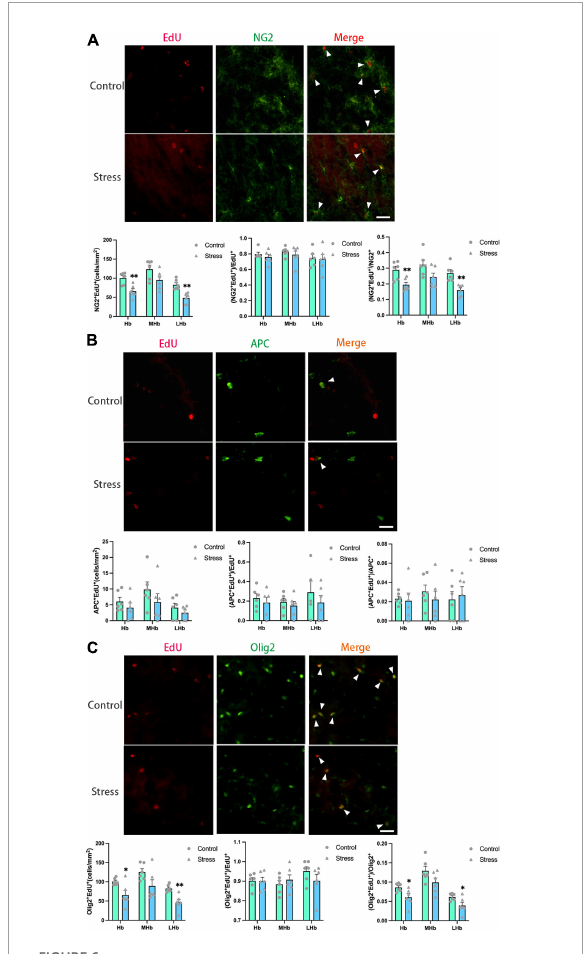
FIGURE6 Chronic social defeat stress (CSDS) reduces oligodendrogenesis in the lateral habenula (LHb) of adolescent mice. (A) Representative images (upper panels) of newly generated cells (EdU + ; red), OPCs (NG2 + ; green), and newly formed OPCs (NG2 + EdU + ; orange) in the habenula (Hb) and the bar graphs (lower panels) showing the number of NG2 + EdU + , the percentage of NG2 + EdU + in the total EdU + cells, and the percentage of NG2 + EdU + in the total NG2 + cells in the total Hb area and its subregions. The white arrowhead indicates the newly formed OPCs. (B) Representative images (upper panels) of newly generated cells (EdU + ; red), mature OLs (APC + ; green), and newly formed mature OLs (EdU + APC + ; orange) in the Hb and the bar graphs (lower panels) showing the number of APC + EdU + , the percentage of APC + EdU + in the total EdU + cells, and the percentage of APC + EdU + in the total APC + cells in the total Hb area and its subregions. The white arrowhead indicates the newly formed mature OLs. (C) Representative images (upper panels) of newly generated cells (EdU + ; red), OLLs, (Olig2 + ; green), and newly formed OLLs (EdU + Olig2 + ; orange) in the Hb and the bar graphs (lower panels) showing the number of Olig2 + EdU + , the percentage of Olig2 + EdU + in the total EdU + cells, and the percentage of Olig2 + EdU + in the total Olig2 + cells in the total Hb area and its subregions. The white arrowhead indicates the newly formed OLLs. Magnification: 100 × . Scale bars: 25 µ m. Data are expressed as mean ± SEM. The number of animals used is as follow: NG2 + EdU + (control, n = 6; stress, n = 6); APC + EdU + (control, n = 6; stress, n = 6); Olig2 + EdU + (control, n = 6; stress, n = 6). ∗ P < 0.05, ∗∗ P < 0.01, Stress vs.